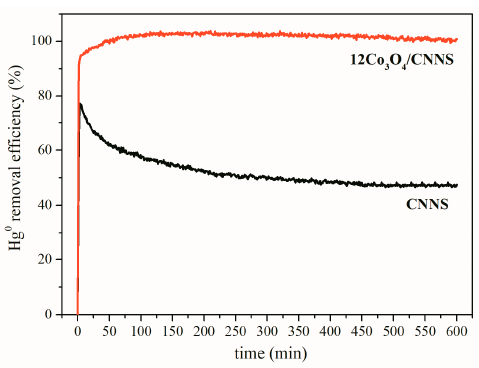
Figure 10. The performances of CNNS and 12Co 3 O 4 /CNNS towards elemental mercury removal at 120 °C over 600 min on 5% O 2 /N 2 stream.